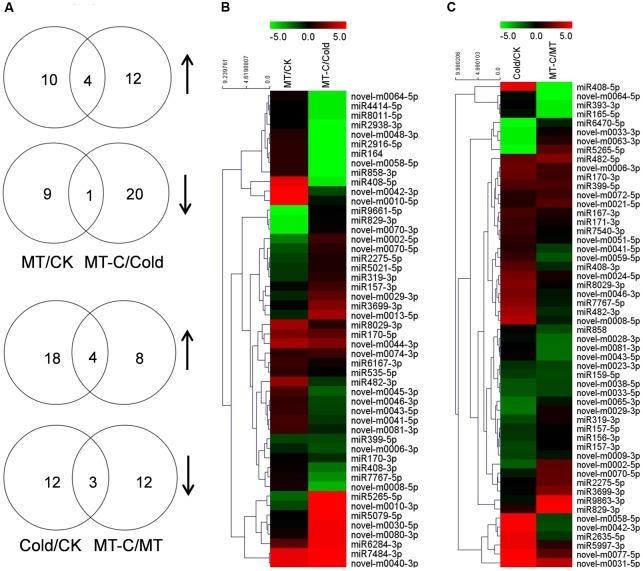
Analysis of differentially expressed miRNAs induced by melatonin or cold stress.
(A) The Venn diagram illustrates number of up- (n-resize) and downregulated (s-resize) miRNAs in comparison of MT/CK, MT-C/Cold, Cold/CK, and MT-C/MT. Up- or downregulation of miRNAs was taken into account when a log2 fold change >1, and P-value <0.01. Heat map showing (B) melatonin or (C) cold induced differentially expressed miRNAs and Clustering analysis according to expression pattern. Complete hierarchical clustering carried out using Euclidean distance, color coding was done according to the scale given. Green indicates downregulation and red upregulation. CK, Control; MT, Melatonin; Cold; MT-C, Melatonin+Cold.